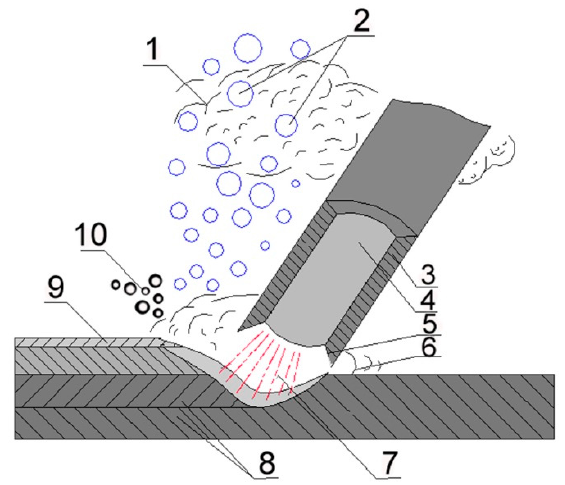
Figure 1. Wet welding by covered electrodes schema. 1: water vapor, 2: gas bubbles, 3: flux coating, 4: wire, 5: melting flux coating, 6: liquid metal, 7: electric arc, 8: base materials, 9: slag, 10: gas from melting flux coating. Table 3. Welding parameters for specimens S1 and